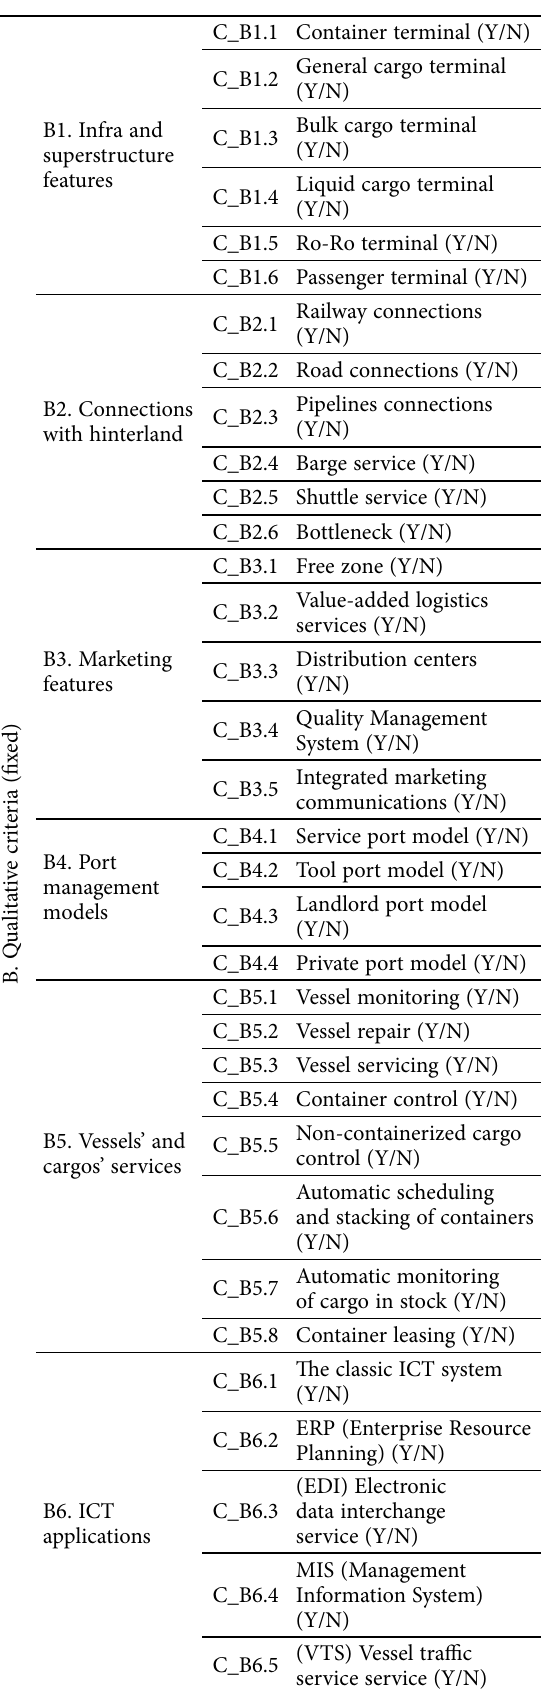
Table 6. Qualitative